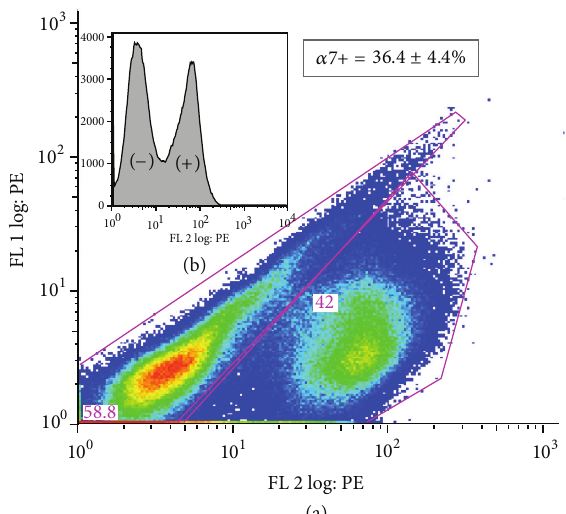
Figure 3: Expression of 𝛼 7 in a mixed cell population. (a) 𝛼 7 PE (b) expression